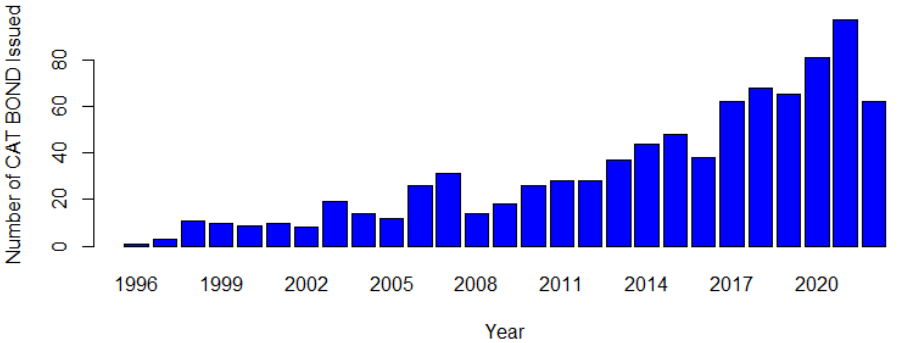
Figure 1. Number of CAT BONDs issued annually from 1996 to October 2022, source: www.artemis.bm (accessed on 20 October 2022), data processed using Rstudio